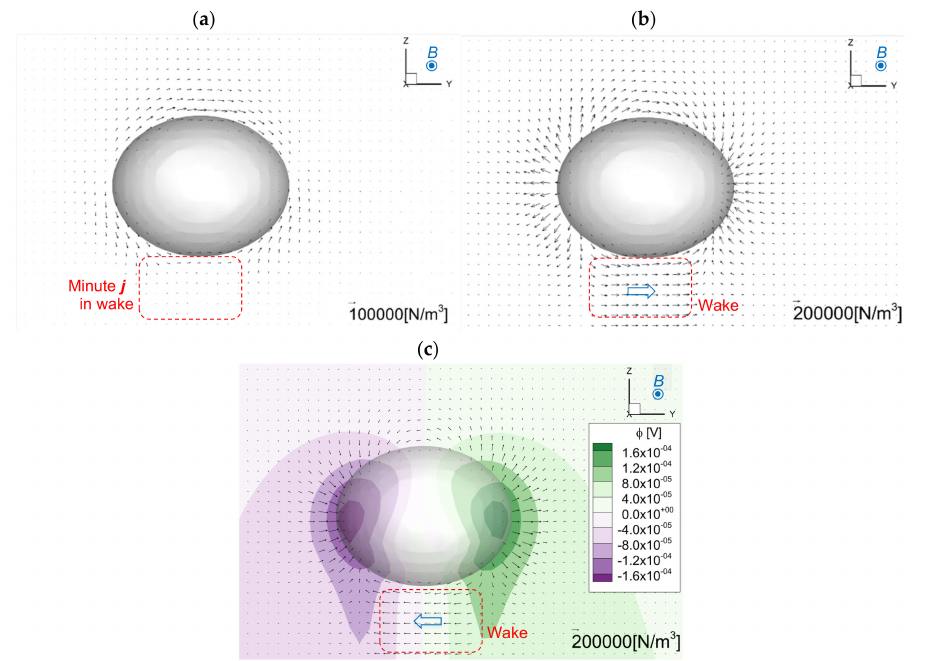
Figure 28. Distributions of the electric current vectors and its components in the x = 0 plane for B 0 = 1.12 T: ( a ) j , ( b ) j and ( c ) j together with the electric potential φ as the color contour. The bold B φ blue arrows represent the main feature of the electric current in the wake field indicated by the red frame. The distribution of j does not resemble that of j , especially in the wake region, which is B different from the condition in lower magnetic field intensity, as shown in Figure